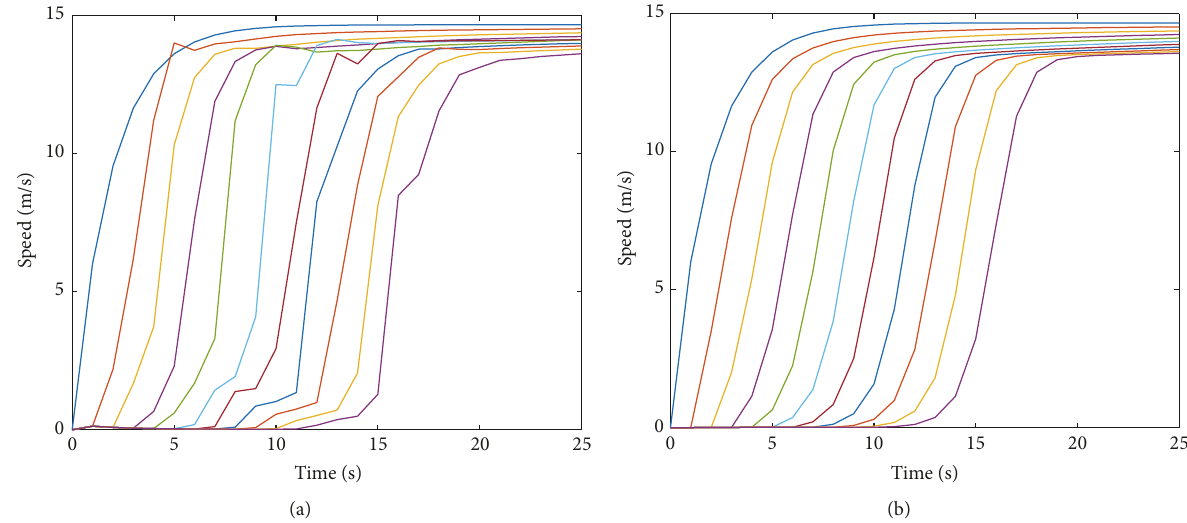
Figure 6: Velocity evolution curves of the starting process of (a) the proposed model and (b) FVD model ( 𝜆 = 0.45 , 𝑝 1 = 0.2 , 𝑝 2 = 0.05 , and 𝑝 = −0.2 ). 3